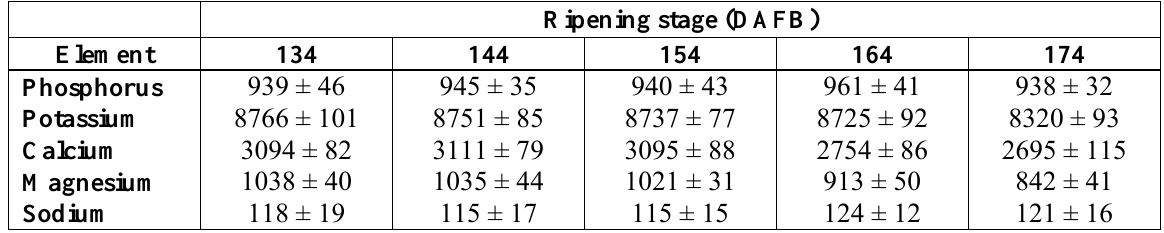
Table 1. The changes in the content of macroelements of phosphorus, potassium, calcium, magnesium and sodium during 5 different ripening stages. All values are introduced as mg kg -1 (dry matter,